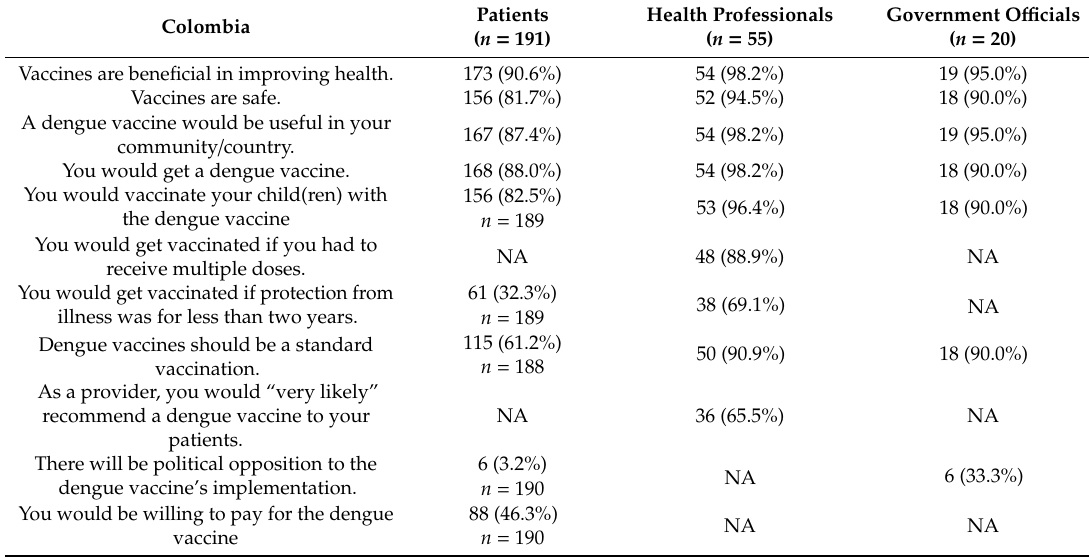
Table 1. Attitudes towards vaccines. Percentage of respondents who “agree” with the following statements. NA—not applicable (the question was not posed to this survey group). Patients Health Professionals Government O ffi cials Colombia ( n = 191) ( n = 55) ( n = 20) Vaccines are beneficial in improving health. 173 (90.6%) 54 (98.2%) 19 (95.0%) Vaccines are safe. 156 (81.7%) 52 (94.5%) 18 (90.0%) A dengue vaccine would be useful in your 167 (87.4%) 54 (98.2%) 19 (95.0%) community / country. 168 (88.0%) 54